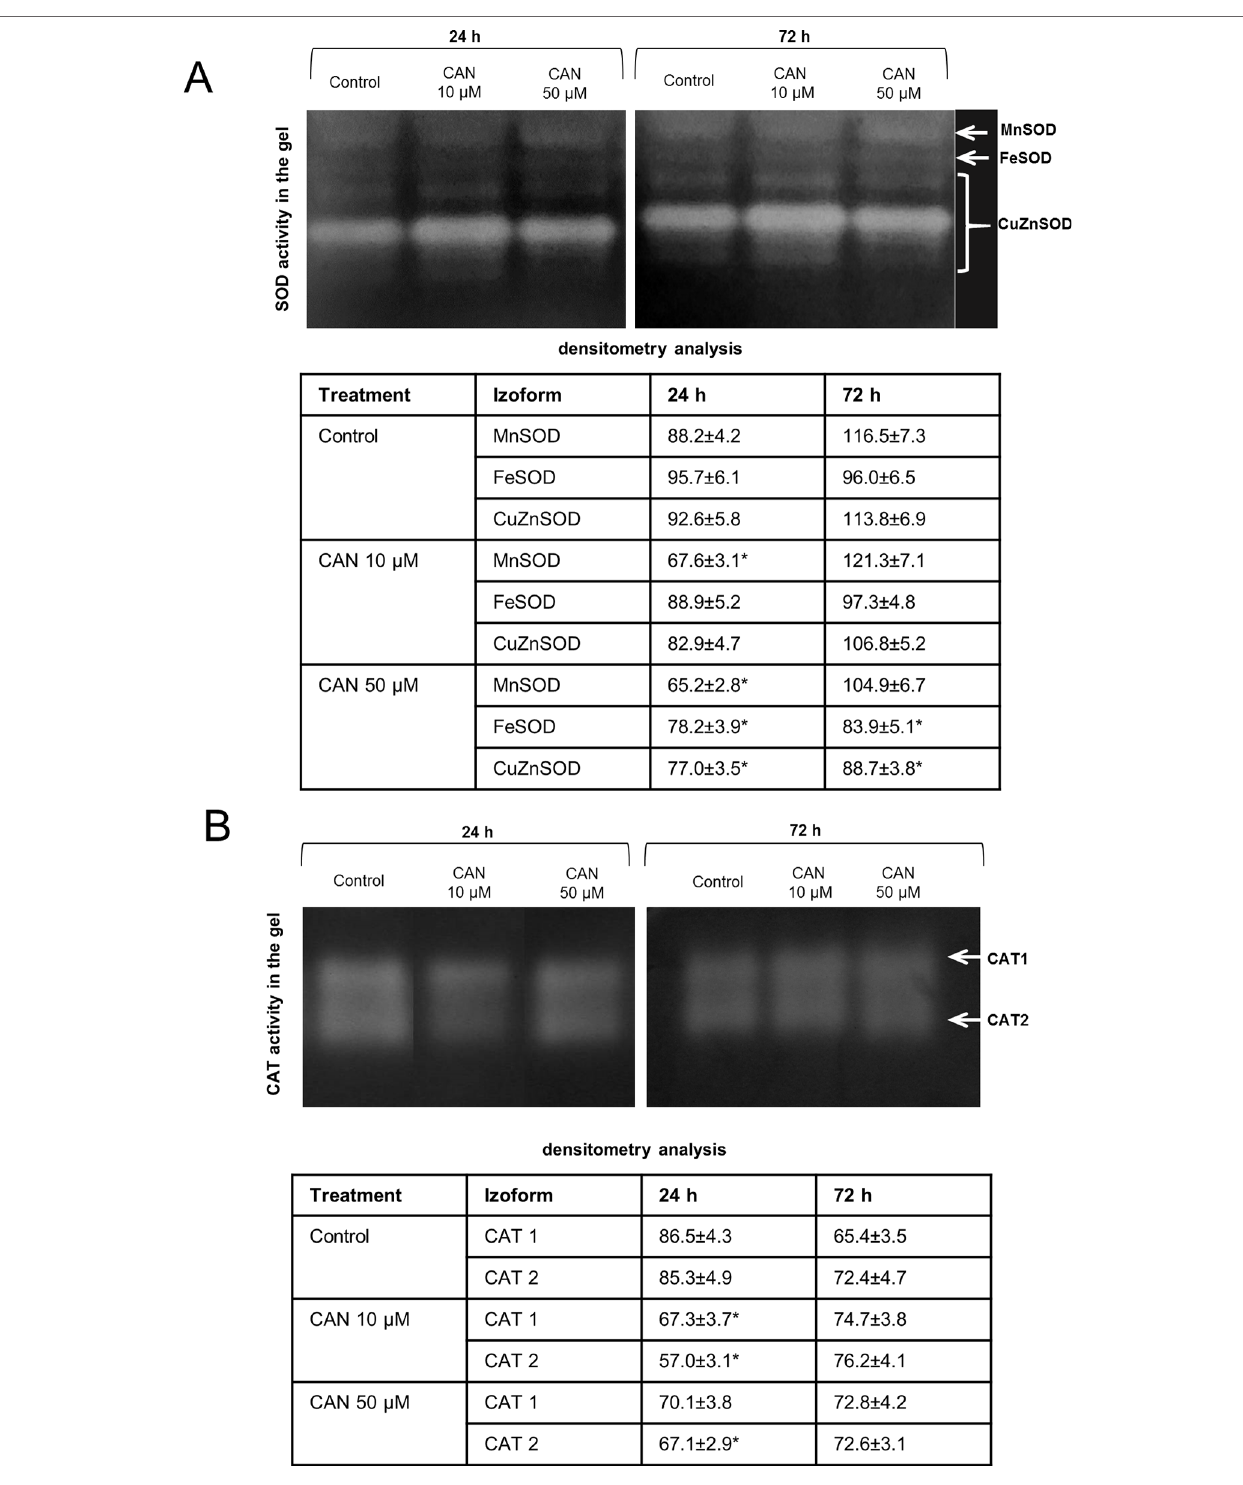
FIGURE 2 | In-gel detection of SOD (A) and CAT (B) activities in extracts from roots of the control seedlings growing in water and roots of seedlings treated with CAN (10 or 50 µM) for 24 and 72 h. Total soluble proteins (20 µg per lane for SOD activity measurement and 10 µg per lane for CAT activity measurement) were electrophoretically separated using 10% (for SOD) and 8% (for CAT) gels under non-denaturing and non-reducing conditions. For visualization of SOD activity gels were incubated in 0.1% (w/v) NBT and then in riboflavin solution, for visualization of CAT activity gels were stained with the mixture of (1:1) 2% iron(III) chloride and 2% potassium ferricyanide. For SOD activity, visualization was done by gel exposure to UV light for 10 min. SOD and CAT isoforms are marked by arrows. Experiments were performed three times, and representative data are